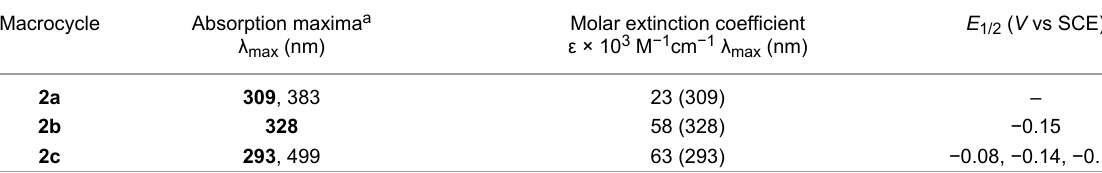
Table 1: Results of UV–vis absorption (in CH 3 CN, 1.0 × 10 − 5 M) and electrochemical (in CH 2 Cl 2 , 0.1 M n -Bu 4 NPF 6 ) studies of macrocycles 2a – 2c at 298 K.